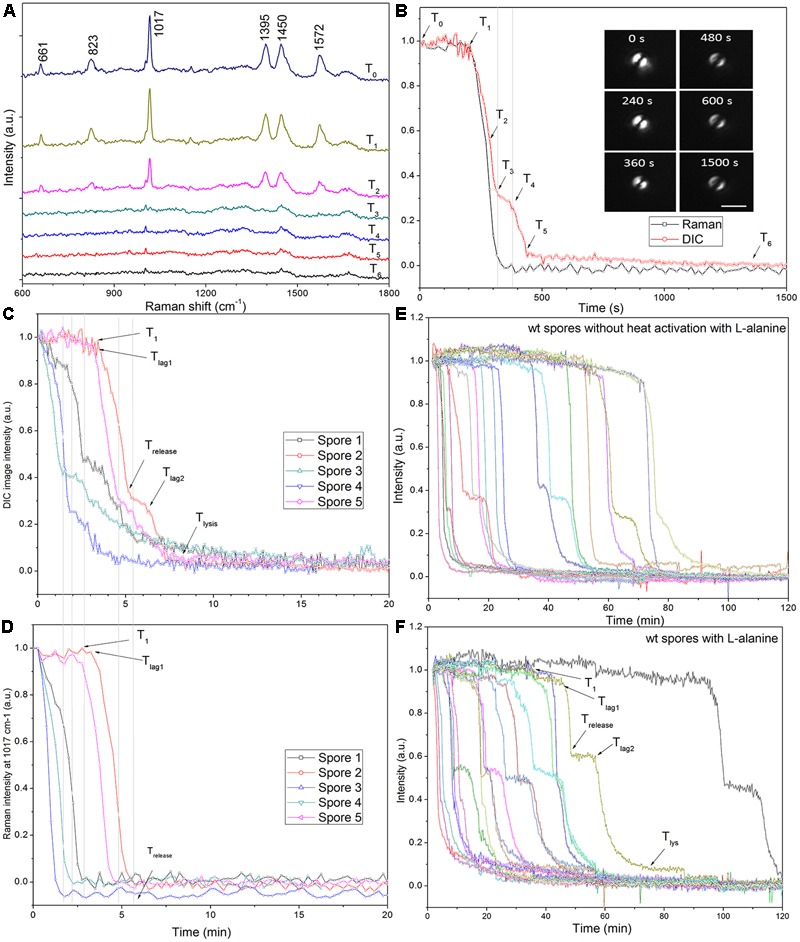
Germination of individual optically trapped wild-type C. sporogenes spores monitored by Raman spectroscopy and/or DIC microscopy. (A) Time-lapse Raman spectra of a single optically trapped spore germinating with 50 mM L-alanine as described in Methods. (B) The peak intensities of the 1017 cm-1 CaDPA-specific Raman band and the DIC image intensities are plotted vs. incubation time and DIC images taken at various times are also shown. Note that the spore appears as a double image due to the differential interference of the illumination polarized light. The laser power was 2.5 mW, Raman acquisition was 15 s per spectrum, and DIC image acquisition was 5 s per image. (C,D) The DIC image intensity (C) and the intensity of the CaDPA-specific Raman band at 1017 cm-1 of five individual spores germinating with 50 mM L-alanine are shown. (E,F) Germination was with 100 mM L-alanine without (E) or with (A–D,F) optimal heat activation and was measured by DIC microscopy, all as described in section “Materials and Methods.” In the experiments shown in (E,F) the level of germination after 120 min was measured by examination of 300 individual spores, and was: (E) 75%; and (F) 95%. In all panels, the DIC image and Raman band intensities in arbitrary units (a.u.) were normalized to 1 based on the respective values at the first time of measurement, and DIC image intensities at the end of the experiment were set at 0.